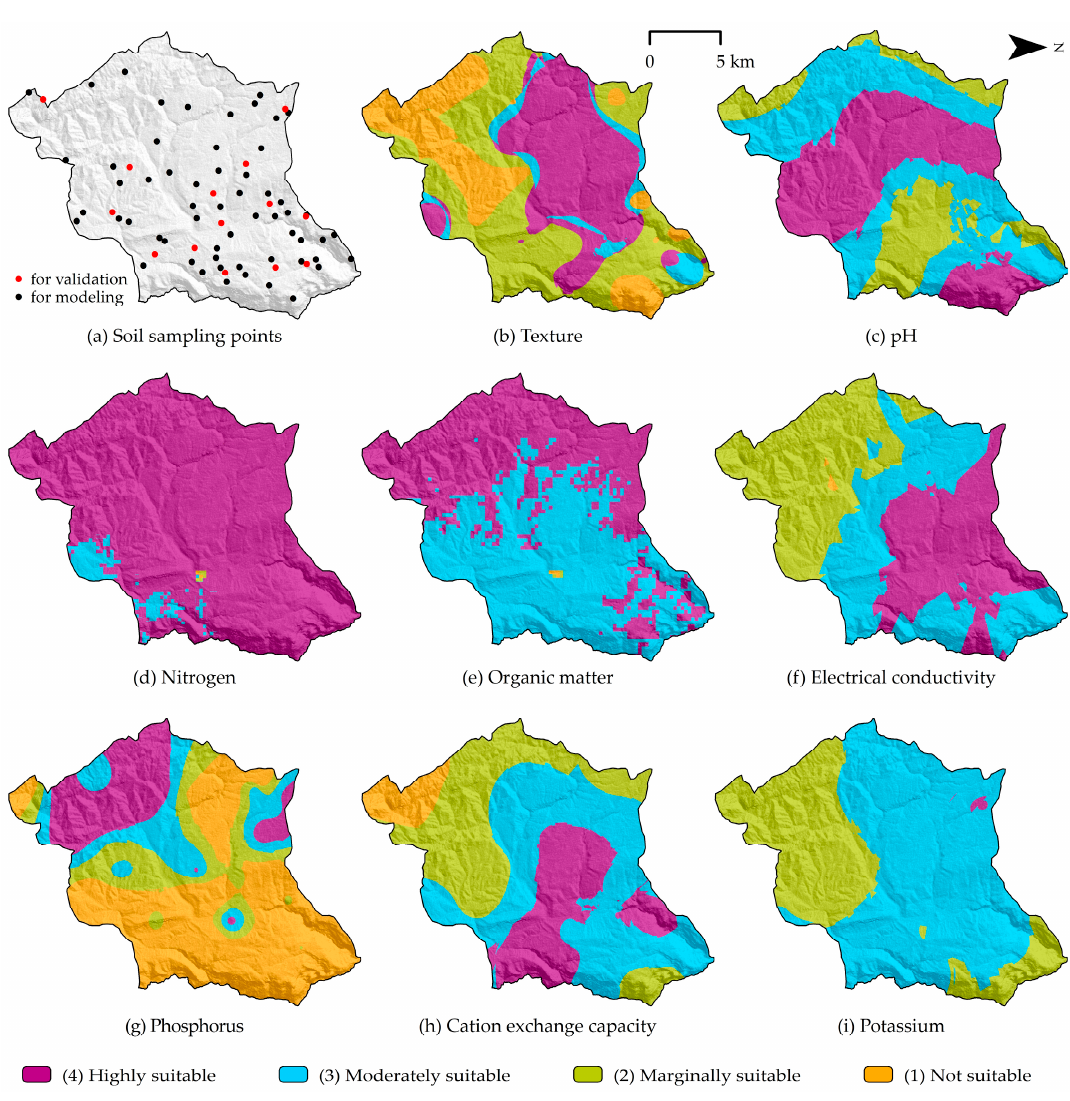
Figure 5. Thematic maps for each edaphological sub criterion for land suitability modelling for potato cultivation in the Jucusbamba and Tincas microwatersheds (Amazonas, NW Peru).